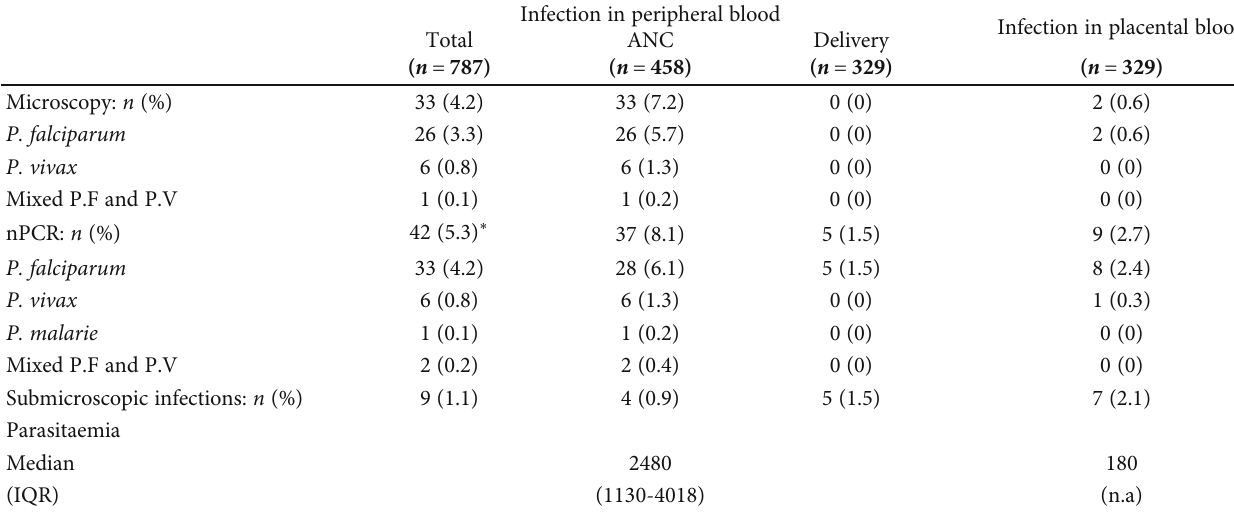
Table 2: Frequency of infection among pregnant women attending antenatal clinics and delivery